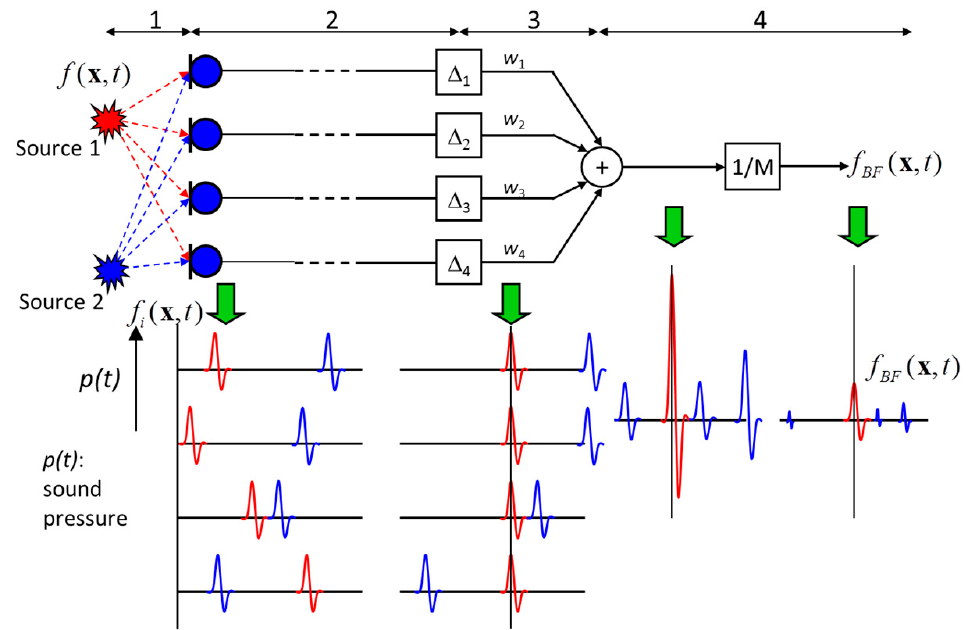
Figure 18. Schematic of delay and sum beamforming in the time domain for acoustic sources [83].